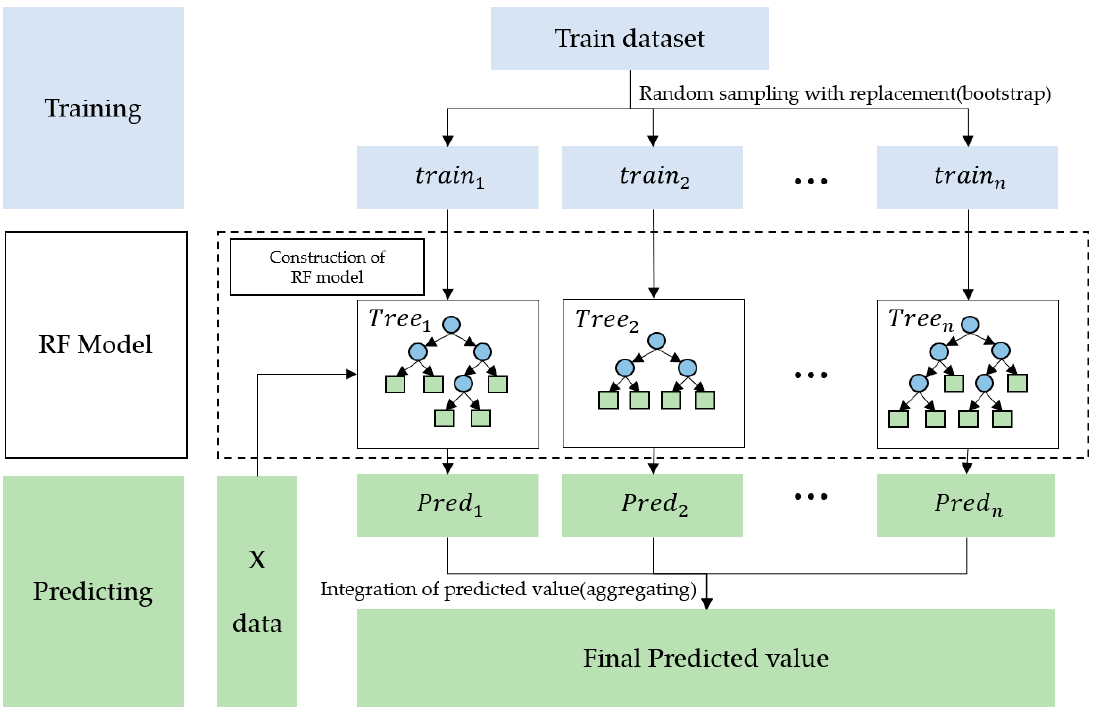
Figure 4. Regression tree node based on RF model. Table 4. Hyperparameters of the random forest (RF) model .